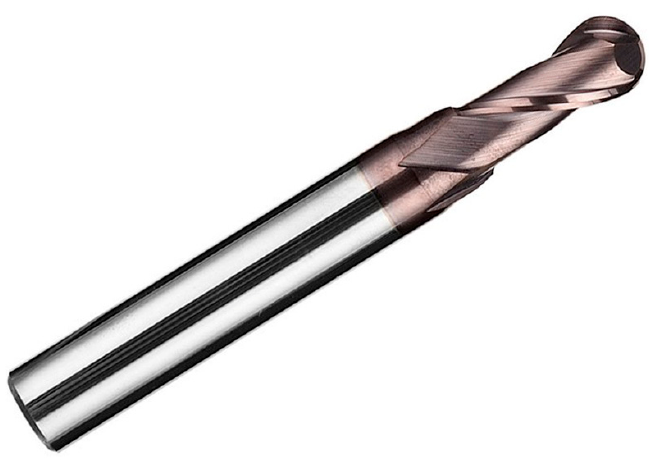
Figure 2. Ball end-milling cutter. Table 1. Main parameters of micromachine equipment.